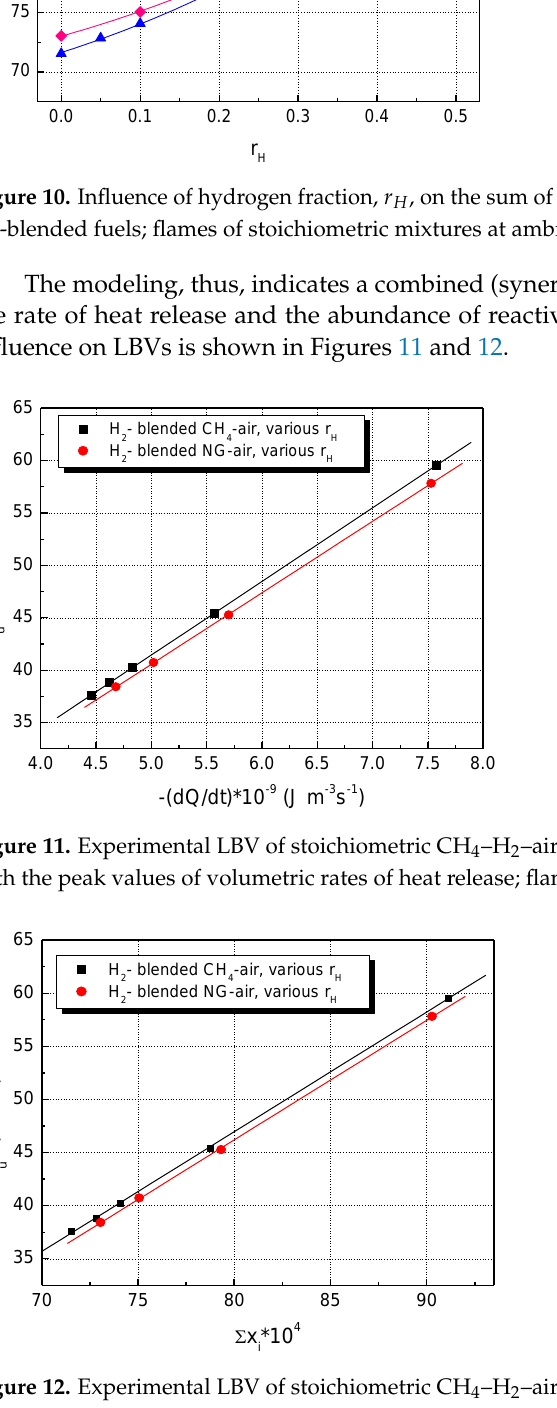
Figure 12. Experimental LBV of stoichiometric CH 4 – H 2 – air and NG – H 2 – air mixtures in correlation with the sum of peak mass fractions of radical species; flames at ambient p 0 and T 0 .